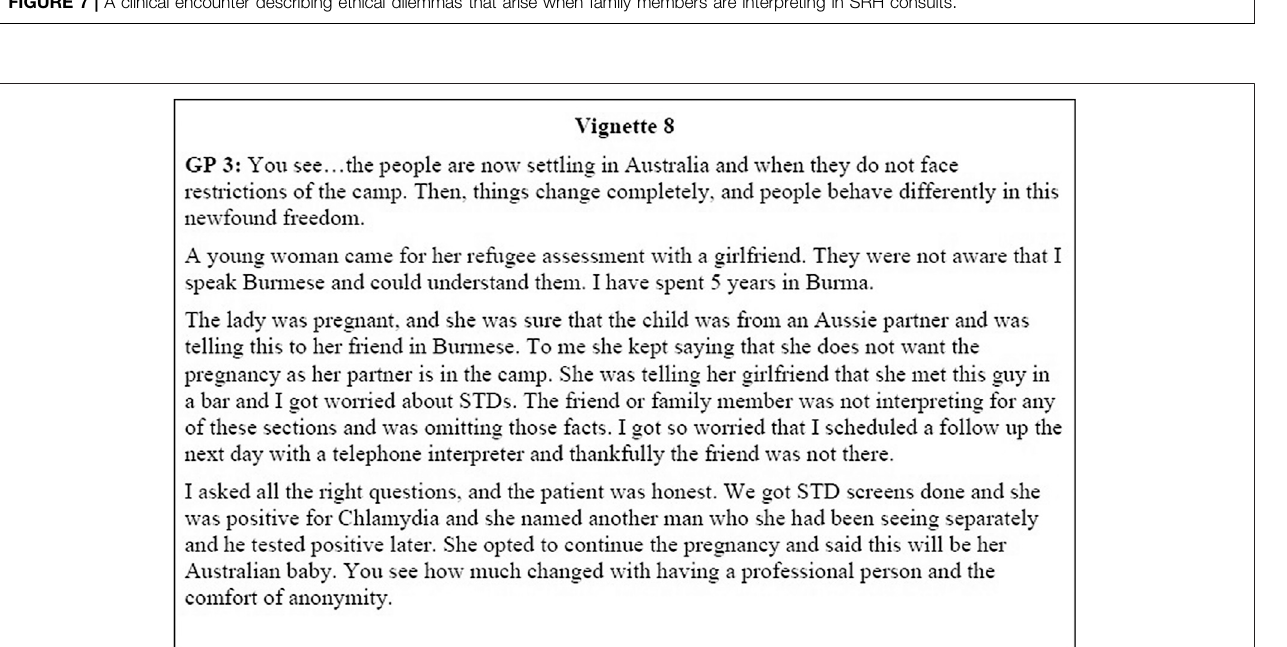
Frontiers in Communication |